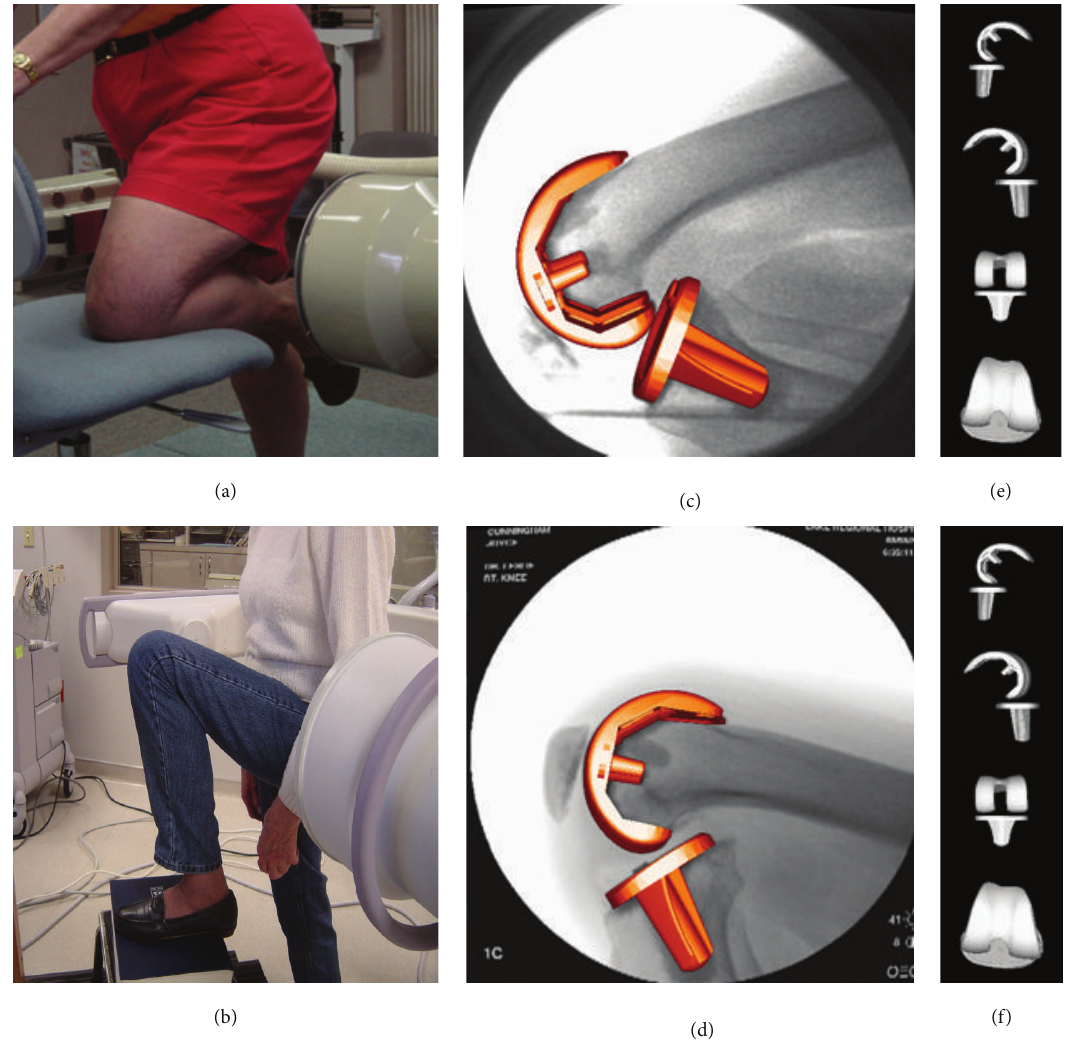
Figure 3: In vivo sagittal plane fluoroscopic images acquired during kneeling and lunge activities (a, b) were analyzed using a shape-matching procedure for fitting the prosthesis surface models to the image silhouettes (c, d) and calculating the position and orientation of the femoral component relative to the tibial component (e,